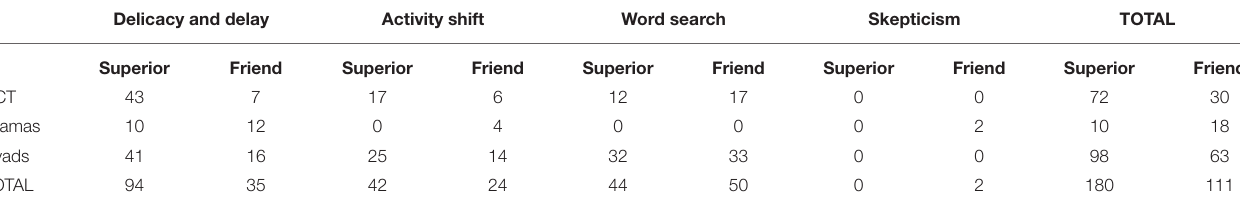
TABLE 2 | Social actions of